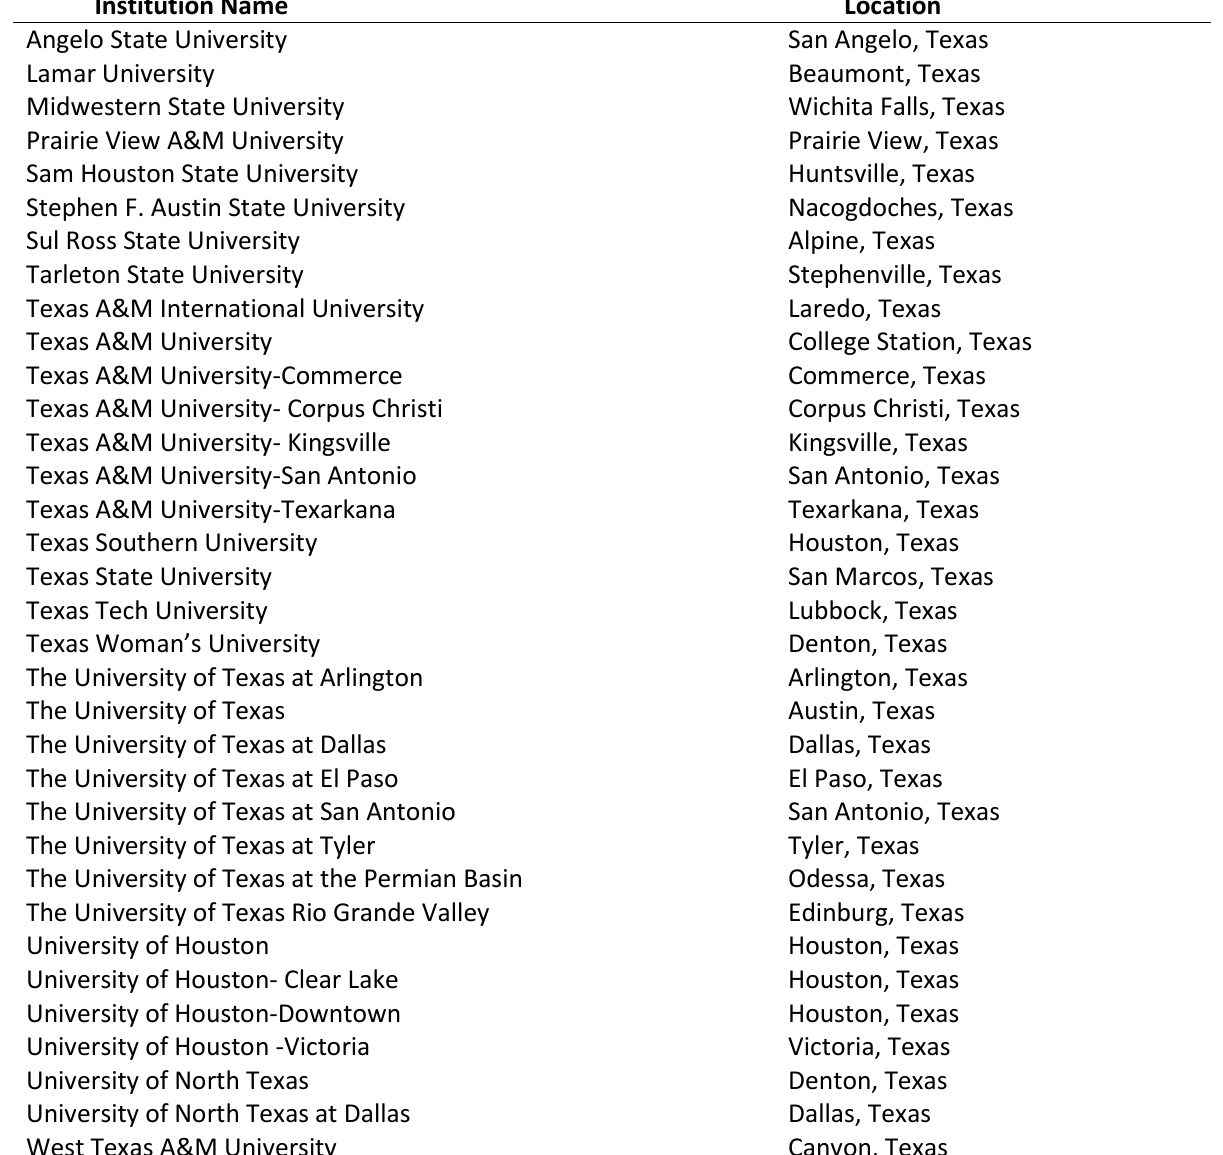
Texas Public Four-Year Universities Offering Bachelor Degrees and Their Geographic